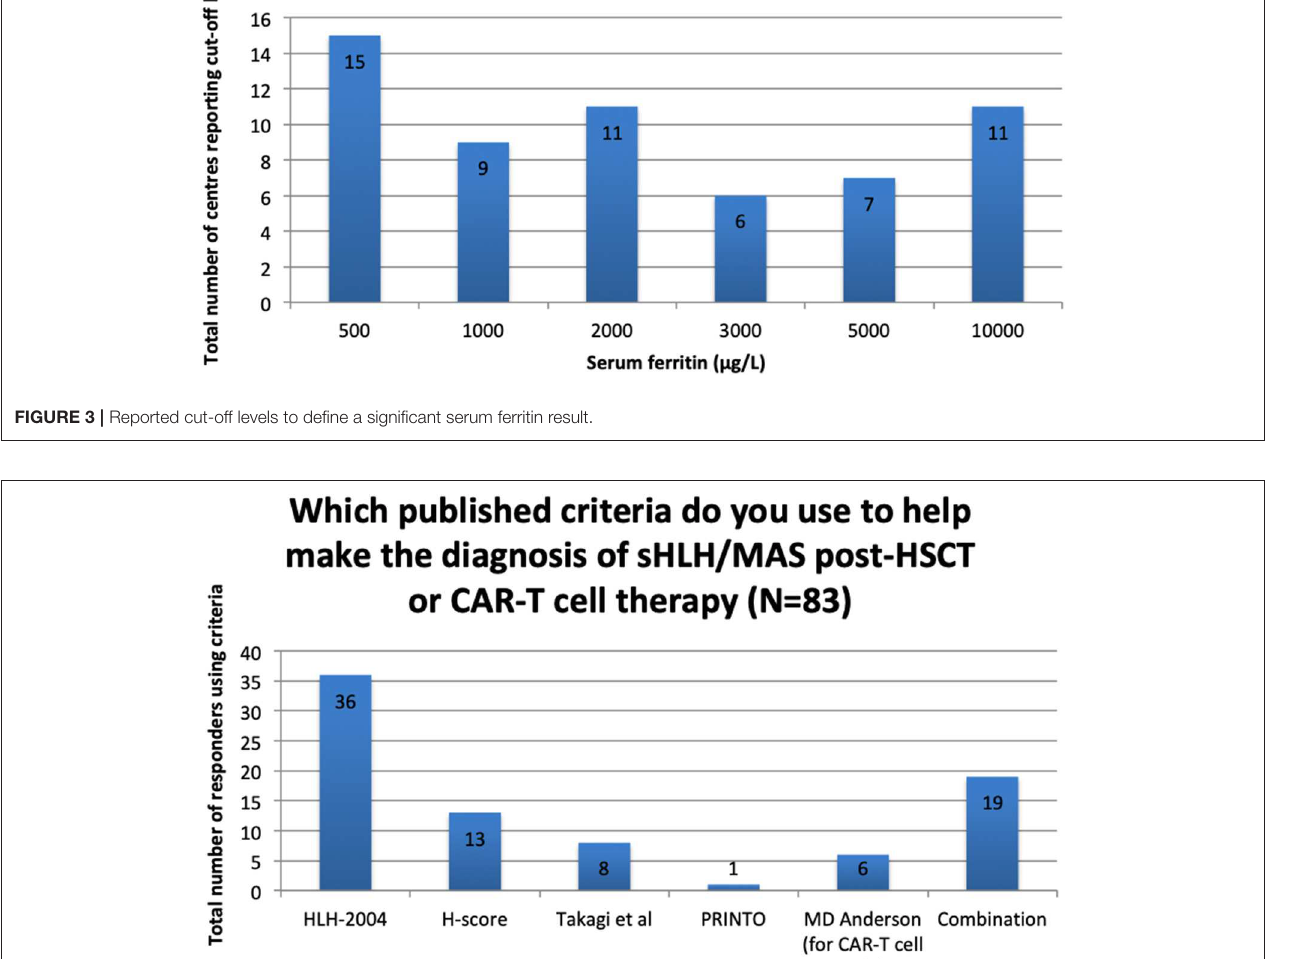
When asked which agents are used to treat sHLH/MAS there were 16 different responses from 97 centres. The most frequently reported combinations were corticosteroids + chemotherapy (25%), corticosteroids + monoclonal antibodies + chemotherapy (15%), corticosteroids + chemotherapy + cytokine blockade (13%), corticosteroids + cytokine blockade (12%), and corticosteroids alone (10%). In terms of specific agents reported as being used in the management of sHLH/MAS, the most common were etoposide ( n = 17), rituximab ( n = 8), and tocilizumab ( n = 7). A range of other agents were reported including Cytosorb R (cid:13) , ruxolitinib, CSA, IVIG, anakinra, ATG, alemtuzumab, methotrexate, vincristine, baricitinib, and